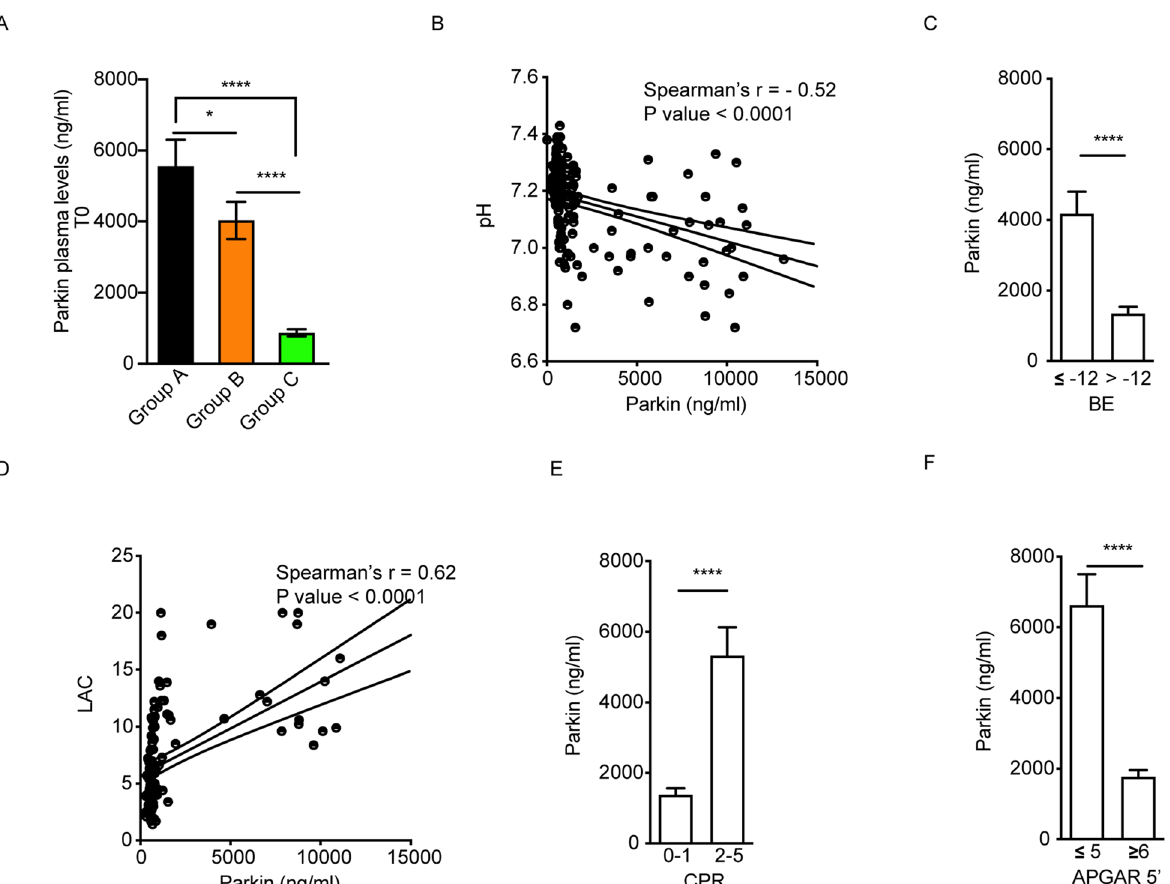
Figure 1. Investigation of mitophagy in newborns at birth and correlation with clinical endpoints. ( A ) Parkin plasma levels measured by ELISA in healthy, babies not needing TH and severe HIE newborns. ( B ) Correlation between Parkin and pH at birth. ( C ) Parkin level stratification according to the base excess score in the whole cohort. ( D ) Correlation between Parkin and lactate release at birth. ( E ) Parkin level stratification according to resuscitation-at- birth score in the whole cohort (0–1 = CPAP assistance, 2–5 = from PPV to drugs). ( F ) Parkin level stratification according to Apgar score at 5 min in the whole